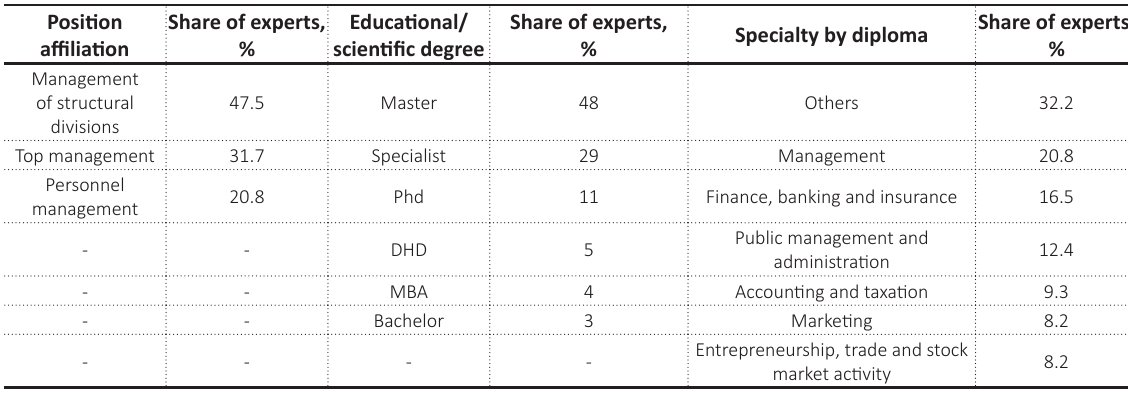
Table A3 (cont.). Expert survey